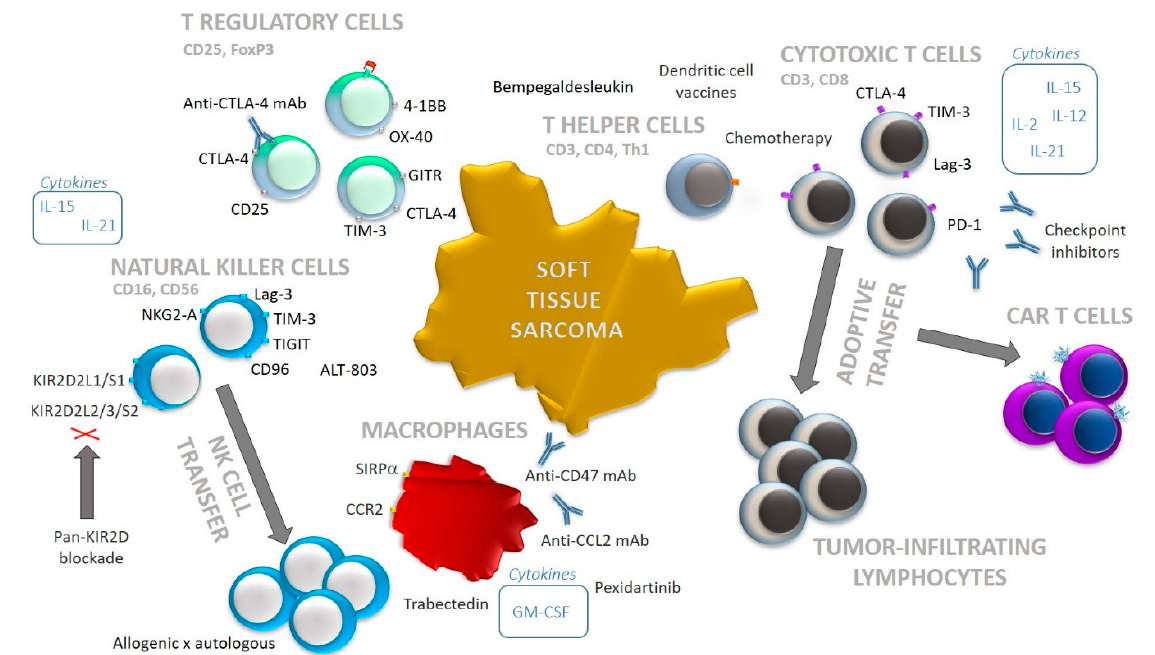
Figure 2. A schematic diagram for major cell populations infiltrating the tumor microenvironment of STSs and an overview of different therapies targeting these populations. Surface receptors can be targeted with monoclonal antibodies (mAbs), and diverse cytokines serve as potent promotors of cell functions. CD3 + T cells and natural killer (NK) cells can be ex vivo expanded and adoptively transferred to a patient. Moreover, a generation of chimeric antigen receptor (CAR) T cells is allowed by a genetic modification of T cell receptor (TCR). Protumorigenic (M2) macrophages, as well as T regulatory cells, can be selectively depleted by synthetic agents or mAbs. The phagocytic capacity of macrophages, on the other hand, is secured by an administration of anti-CD47 mAbs. NK cells can be efficiently activated by a pan-KIR2D blockade together with IL-15 superagonist. Multiple immunotherapeutic approaches can be combined.